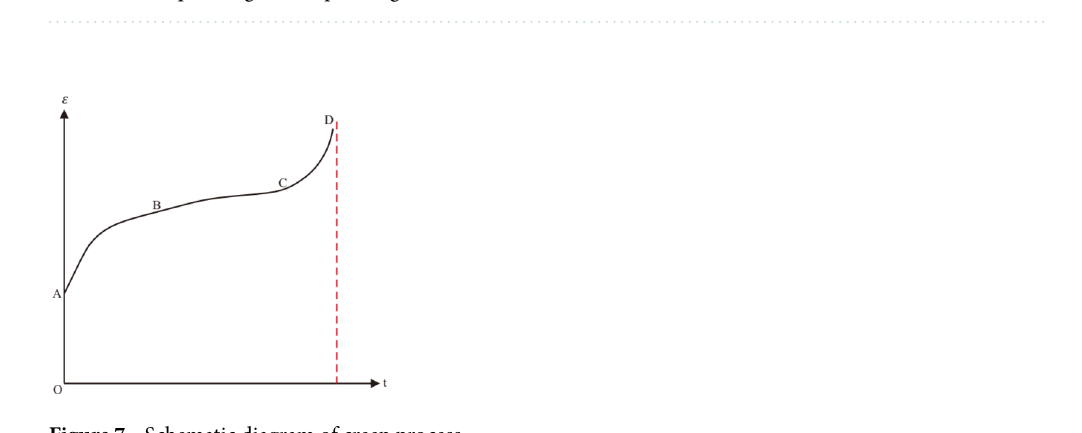
Figure 7. Schematic diagram of creep process.